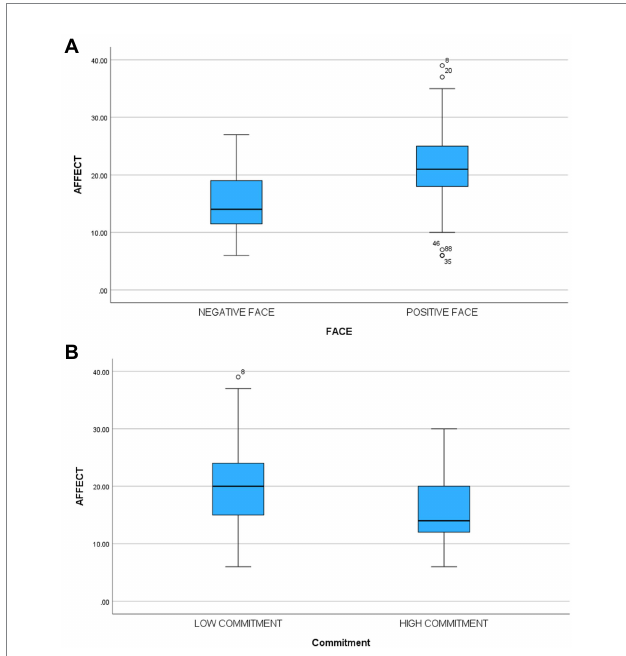
FIGURE 2 (A) Box plot of impact of face threat on affect. (B) Box plot of impact of commitment on